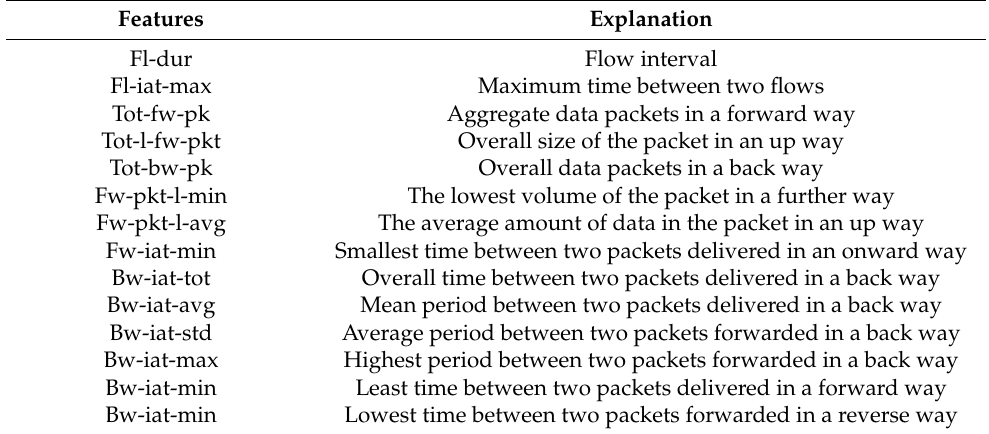
Table 2. Overview of the extracted features of the CSE-CIC IDS2018 ID dataset.